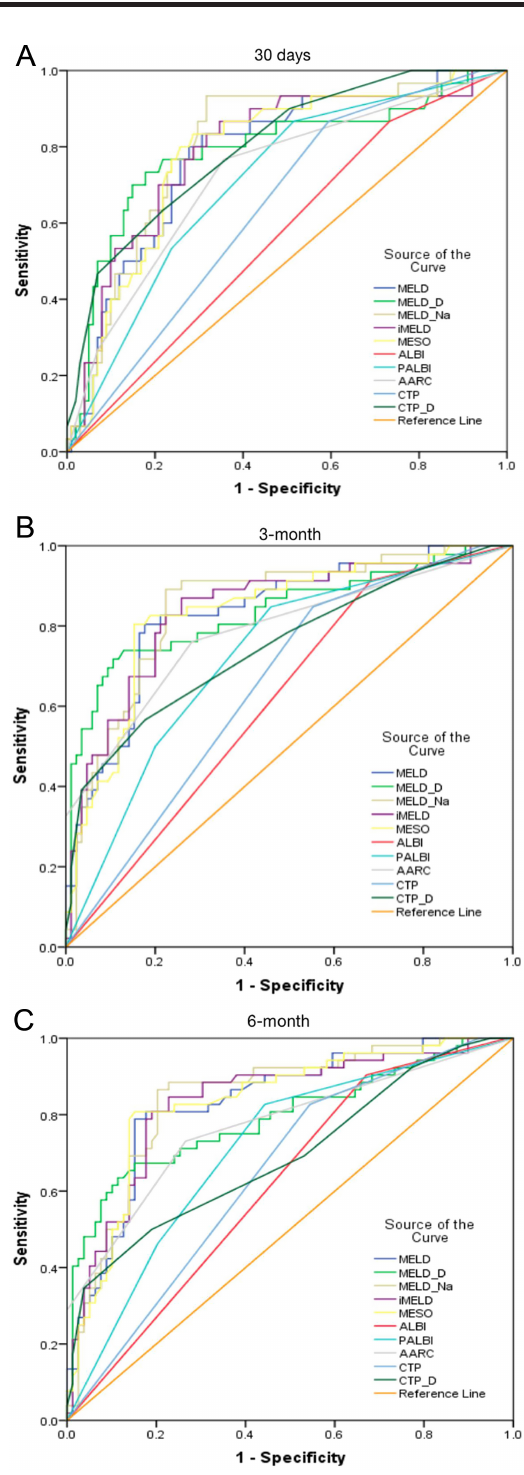
Figure 2. AUROCs value of ALBI score and CTP score at 30-day (A), 3-month (B), and 6-month (C). ALBI, albumin-bilirubin; CTP, child-turcotte-pugh score; AUROCs, areas under receiving-operator characteristics